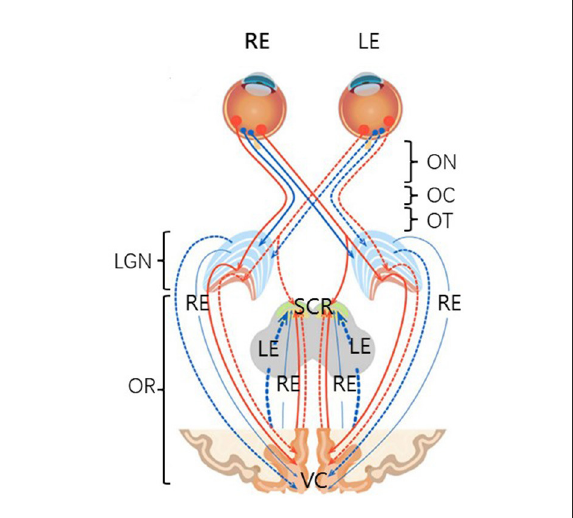
FIGURE1 A schematic anatomical overview of the visual system. There are six major subdivisions, including optic nerve (ON), optic chiasm (OC), optic tract (OT), lateral geniculate nucleus of the thalamus (LGN), optic radiation (OR), and visual cortex (VC). Four non-decussating fiber pathways (nasal fibers, blue, and orange) connect the optic nerve and the optic tract in the same hemisphere, while four decussating fiber pathways (lateral fibers, blue, and orange) connect the optic nerve and the optic tract across the hemispheres. SCR, subcortical